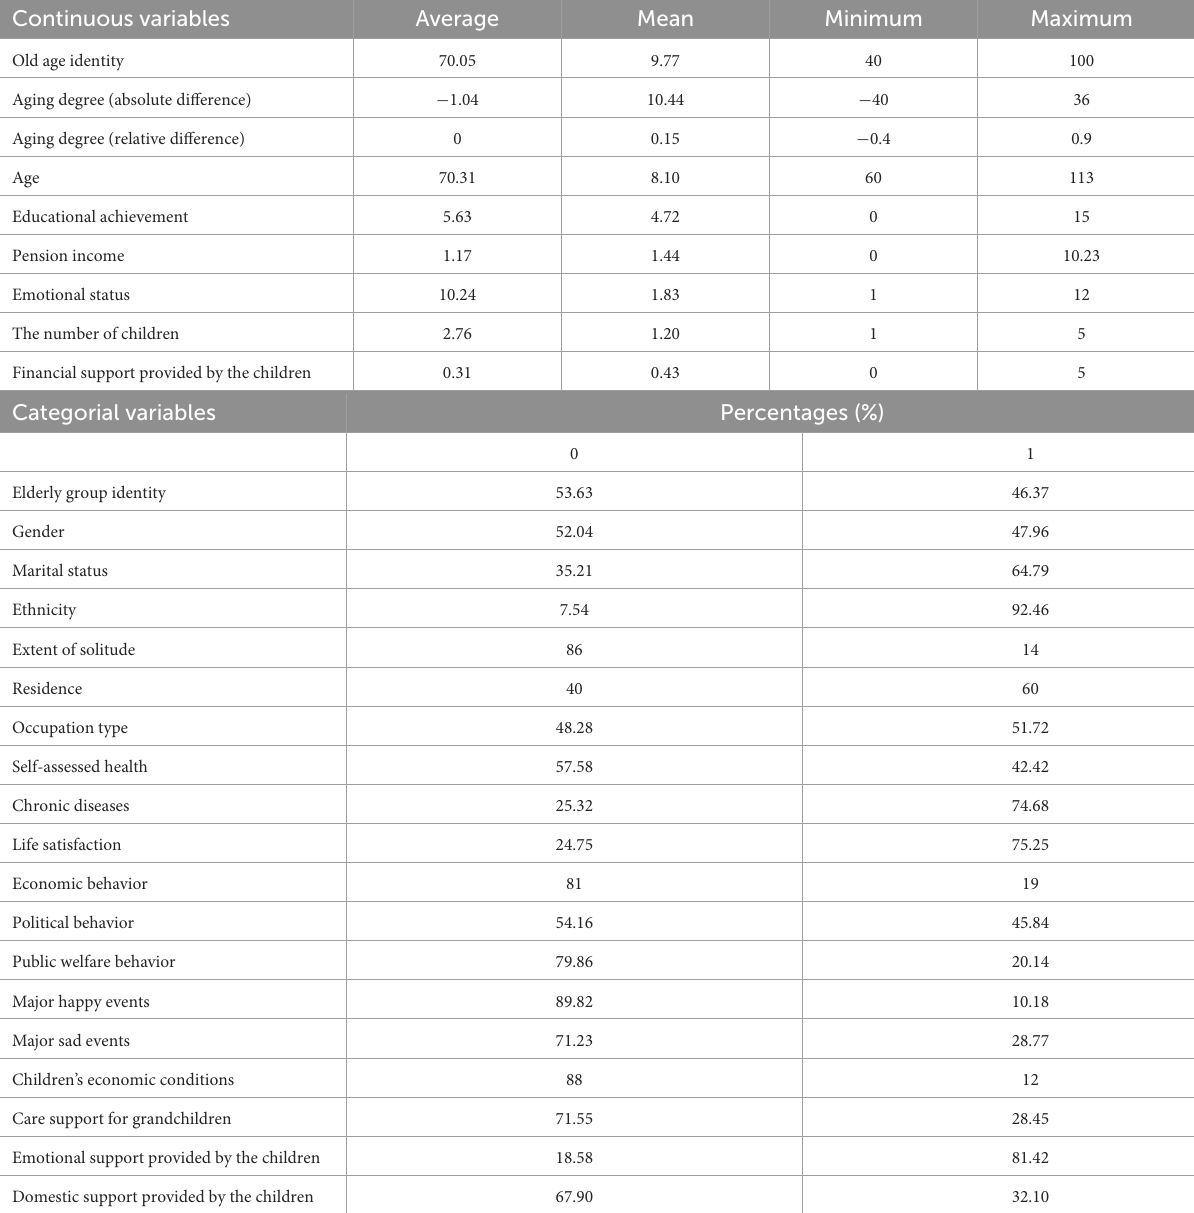
TABLE 1 Descriptive statistics of the